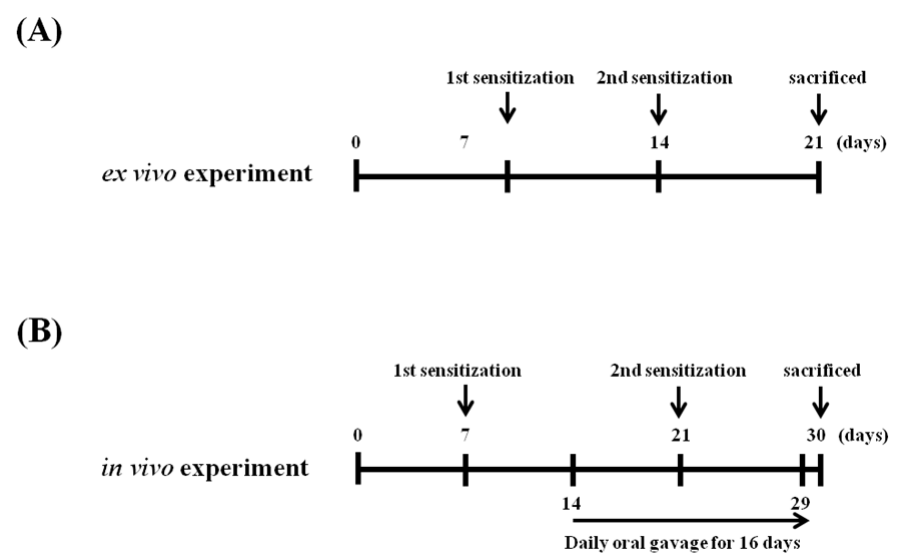
Figure 5. Schamatic diagram of the experiments of ex vivo and in